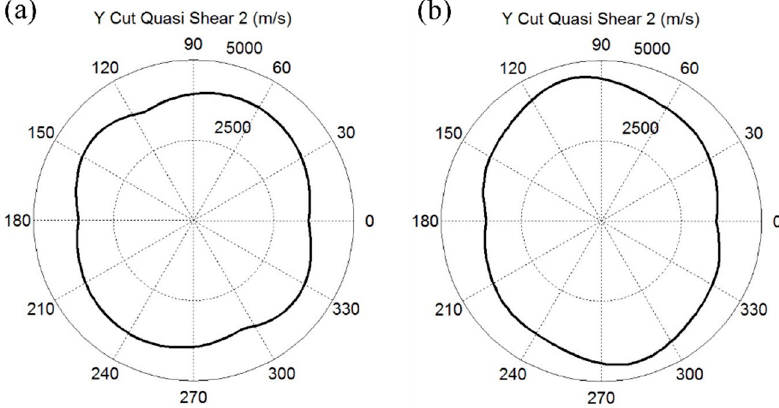
Figure 9. The directional group wave velocity plot in LiNbO 3 for fast transverse wave velocity ( a ) without piezo stiffening ( b ) with piezo stiffening mode.